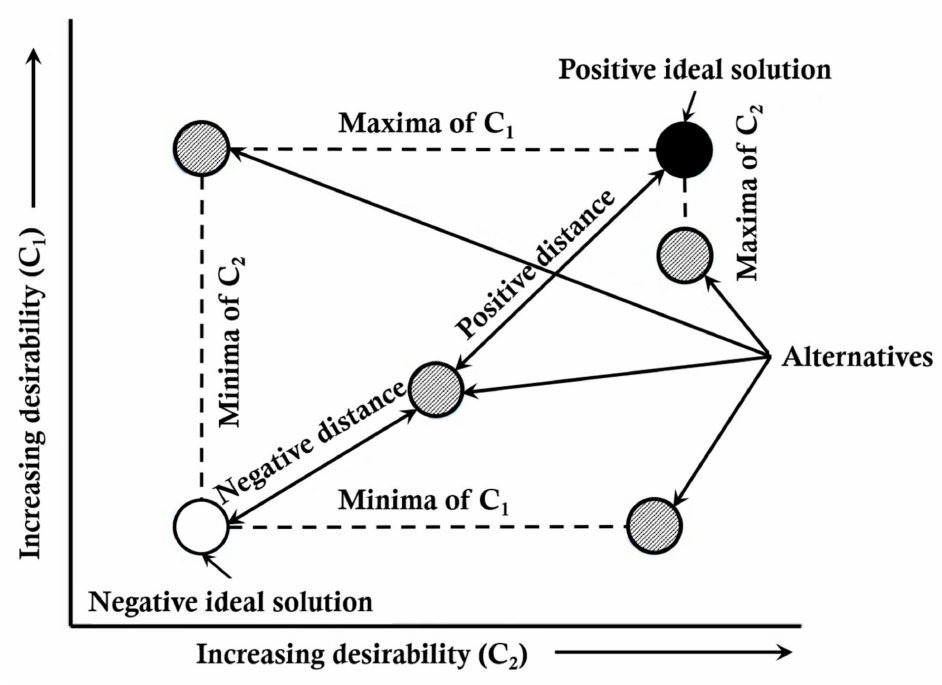
Figure 4. TOPSIS